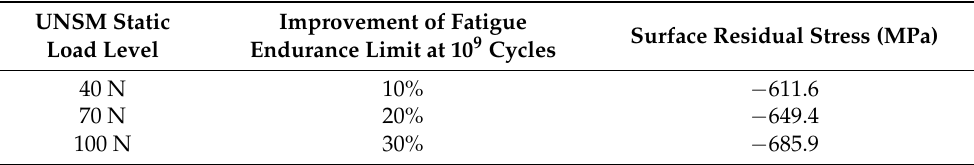
Table 1. Comparison of the improvement of fatigue endurance limit (from rotary bending test) and surface residual stress after processing JIS SCM435 steel specimens with UNSM at different treatment static loads [24].